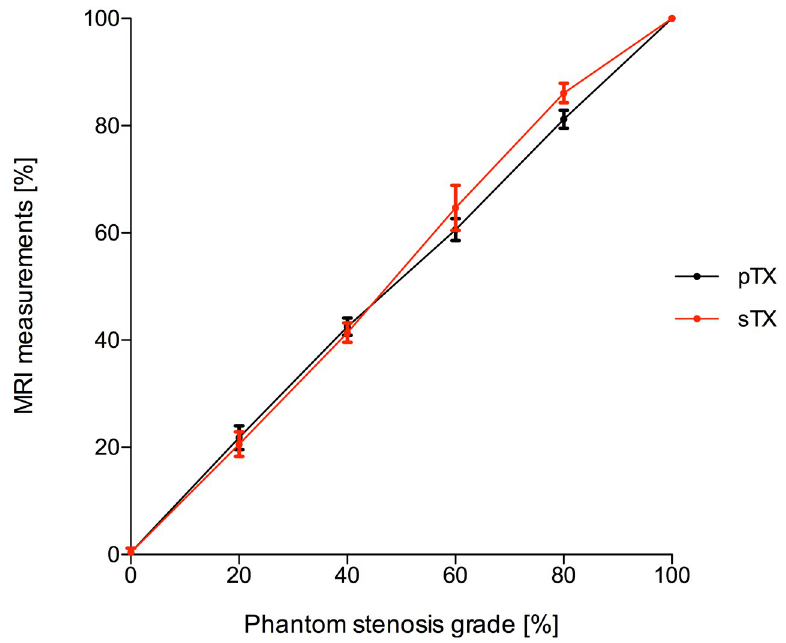
Fig 5. Quantification of stenosis grades in 3D-printed phantom models using a conventional single transmit coil (sTX, red dots) and a parallel transmission (pTX) coil with B 1 -shimming (black dots). Stenosis grades were determined by comparing the minimal luminal diameter at the site of maximal stenosis with normal reference diameters proximal or distal. Error bars denote single standard deviation. In images acquired with the conventional coil, higher grade stenoses were slightly overestimated, whereas pTX with B 1 -shimming enabled significantly (p < 0.01) more precise stenosis quantification. Quantification of stenoses in images of pTX coil without B 1 -shimming was not reasonably achievable in high-grade stenoses due to severe B 1+ -inhomogeneities.